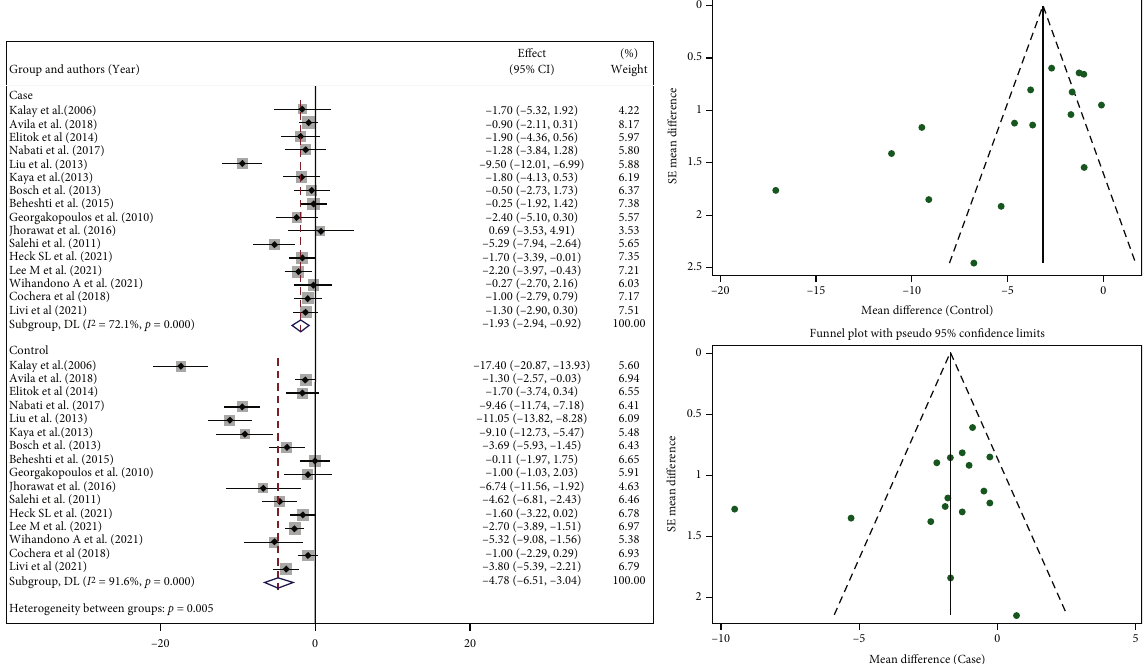
Figure 2: Forest and funnel plot of two group ’ s LVEF changes at the end of